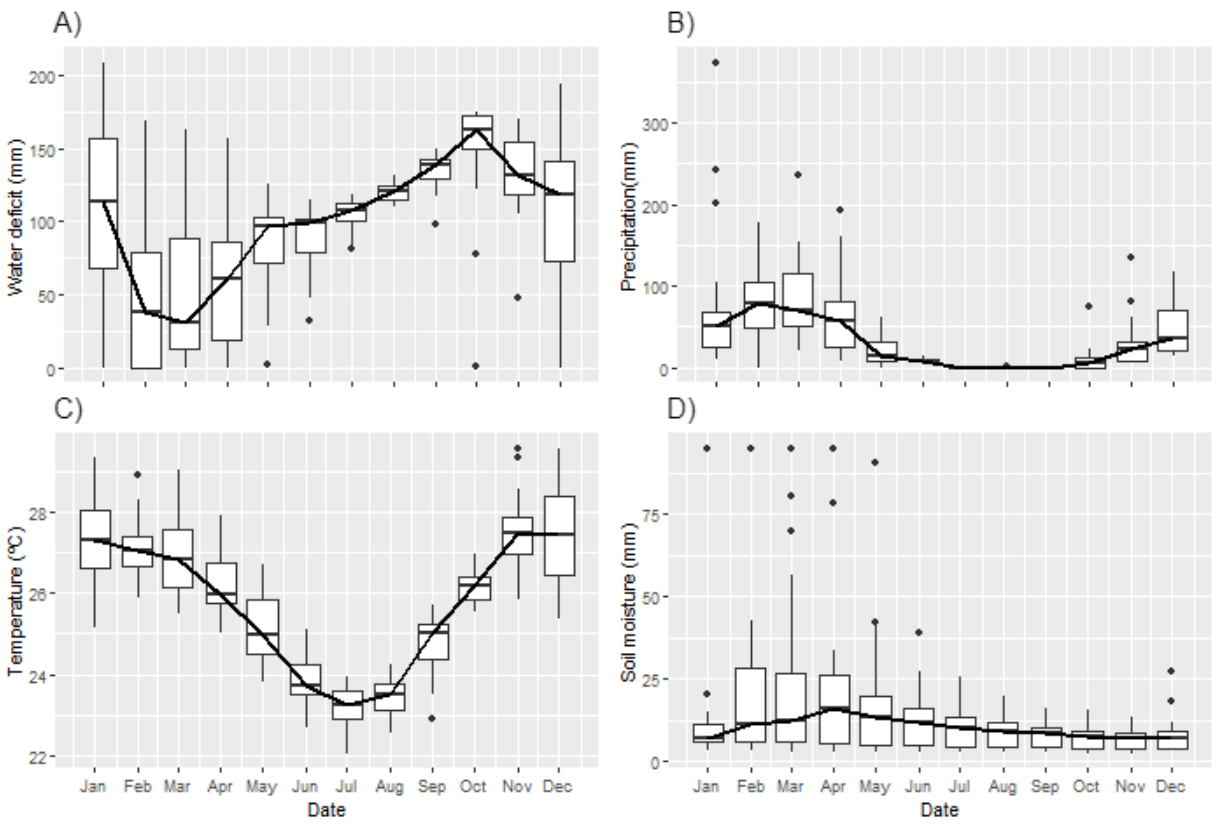
Figure 4. Environment drivers for MSD in ( A ) Water Deficit, ( B ) Precipitation, ( C ) Air Temperature, and ( D ) Soil moisture.